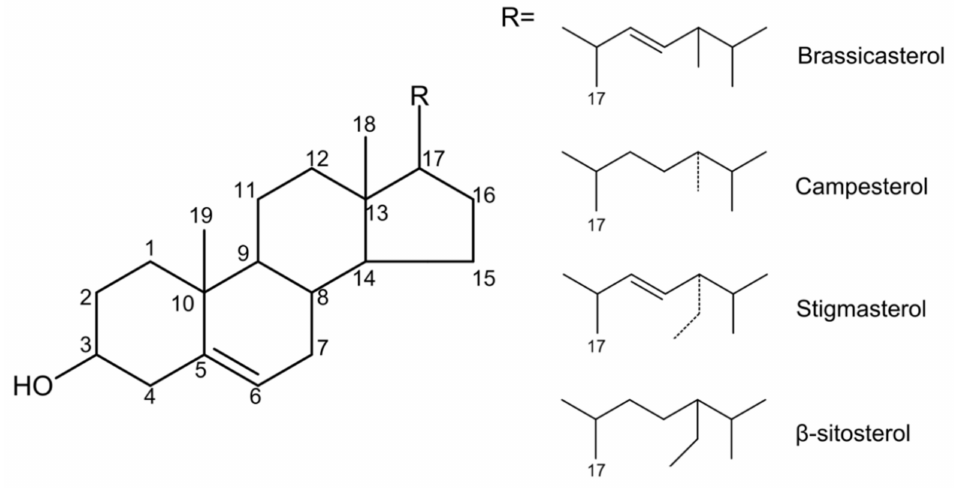
Figure 1. The main chemical structure of different kinds of phytosterols. Most plants in nature contain phytosterols, but the content of phytosterols differs largely among the different parts of the plant. The oils, nuts, beans, and seeds of plants are good sources of phytosterols. Although phytosterols can be detected in fruits and vegetables, their content is relatively low. In olive oil, the content of total phytosterols is 235.9 ± 11 mg/100 g, whereas in the potato, the content of total phytosterols is only 4.3 ± 0.2 mg/100 g [2]. In higher plants, the main phytosterols are β -sitosterol, campesterol, and stigmasterol, and the content of these three sterols can reach more than 80%. For example, in Arabidopsis thaliana , the main sterol is β -sitosterol, accounting for 64%, while other sterols are found, including campesterol (11%), stigmasterol (6%), isofucosterol (3%), and brassicasterol (2%) [17]. In olive flowers, the total sterol level rises from the early stage to the flowering stage and during this period β -sitosterol and cholesterol accumulate, with the content of β -sitosterol even reaching 96% [18]. In peanuts, the seed heart, kernels, and seed coats contain β -sitosterol, campesterol, and stigmasterol with contents of 82.29%, 86.39%, and 94.25%, respectively